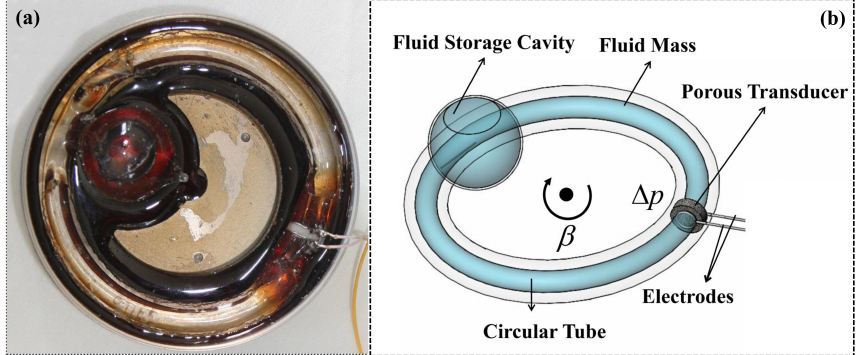
Figure 1. The physical prototype and structure diagram of the liquid circular angular accelerometer (LCAA): ( a ) physical prototype; ( b ) structure